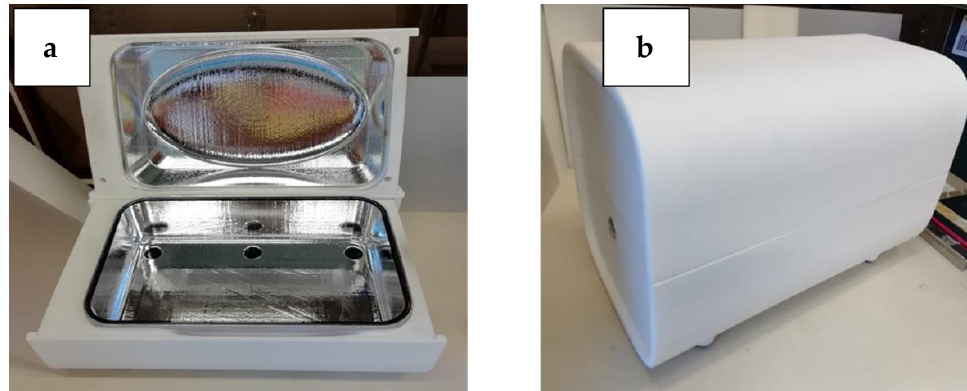
Figure 1. ( a ) Base and lid of the white disinfection box; UV chips are visible in the bottom part. ( b ) Box with the lid closed.